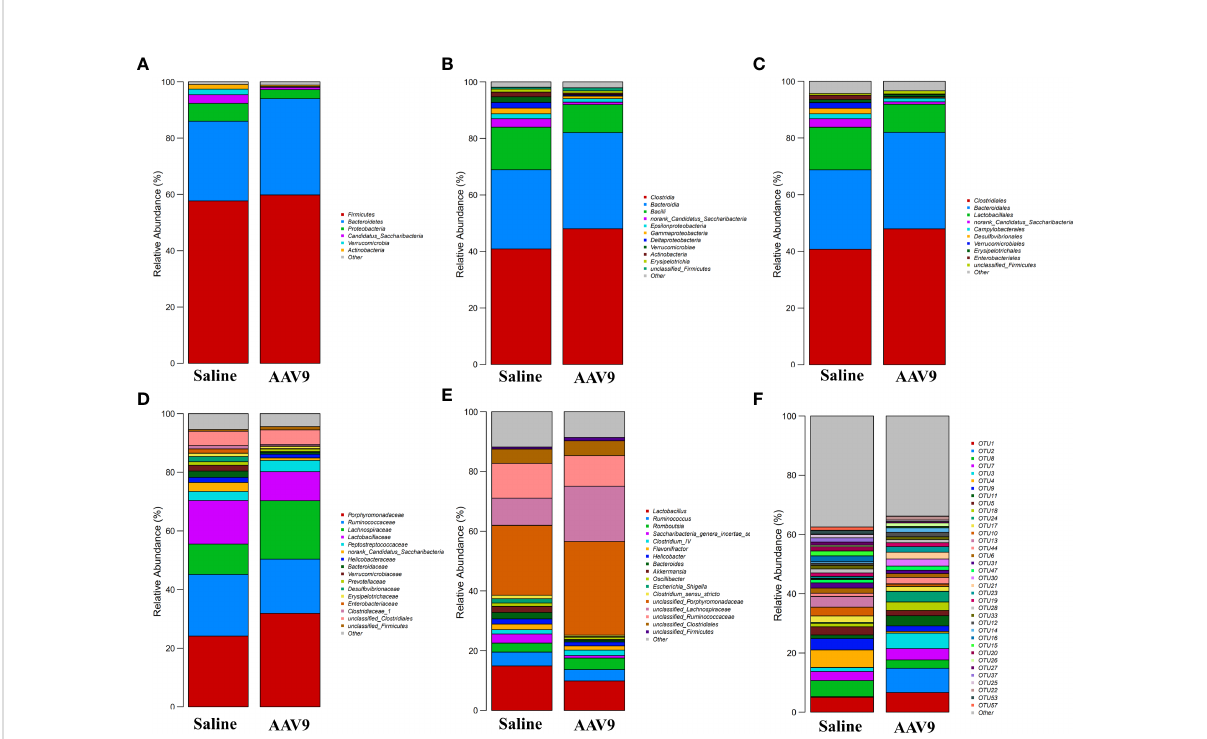
FIGURE 4 Histogram of the relative abundance of dominant species in the two groups. (A – F) Phylum, class, order, family, genus, and OTU levels. The horizontal axis is the corresponding group, and the vertical axis is the relative abundance ratio of species. The colour corresponds to the name of each species at this taxonomic level, and the height of different coloured blocks indicates the relative abundance ratio of different